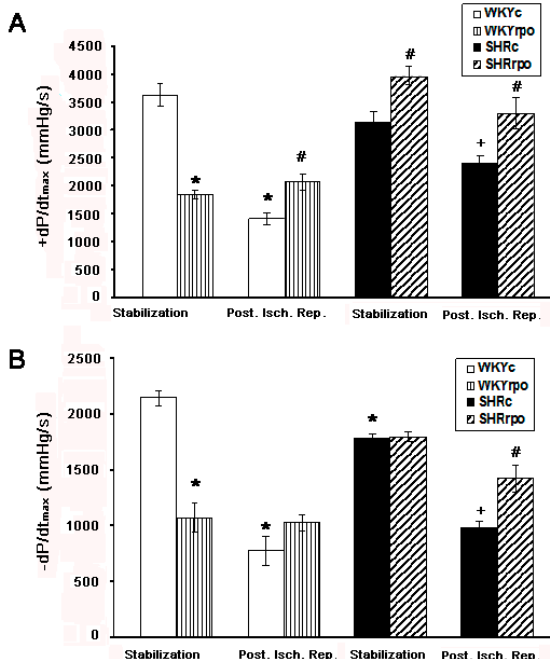
Figure 6. Effect of dietary red palm oil (RPO) supplementation on the contractile and relaxation function of left ventricle in WKY and SHR during stabilization and post ischemic reperfusion (Post. Isch. Rep). +dP/dt—the velocity of contraction ( A ); − dP/dt—the velocity of relaxation ( B ); WKYc—Wistar Kyoto control rats; WKYrpo—WKY treated with RPO; SHRc—Spontaneously hypertensive rats; SHRrpo—SHR treated with RPO. Results are expressed as mean ± SEM; n = 6 in each group; * p < 0.05 versus control rats (WKYc); # p < 0.05 WKY/SHR versus treated with RPO; + p < 0.05 SHRc during stabilization versus SHRc during Post. Isch. Rep.